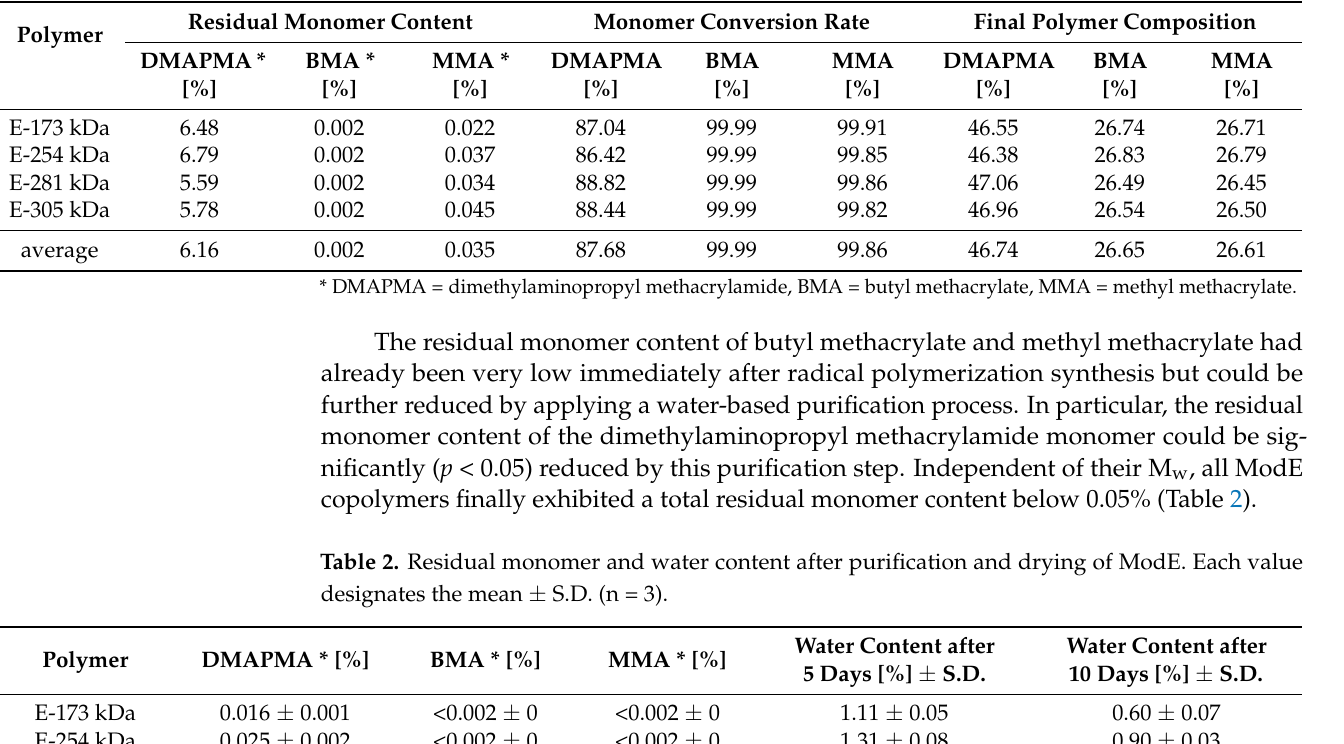
Table 1. Residual monomer content, monomer conversion rate and the final composition of ModE copolymers. Each value designates the mean (n = 3). Since S.D. was <0.04 for DMAPMA and <0.005 for all other reported values, detailed S.D. values are not shown for better overview.